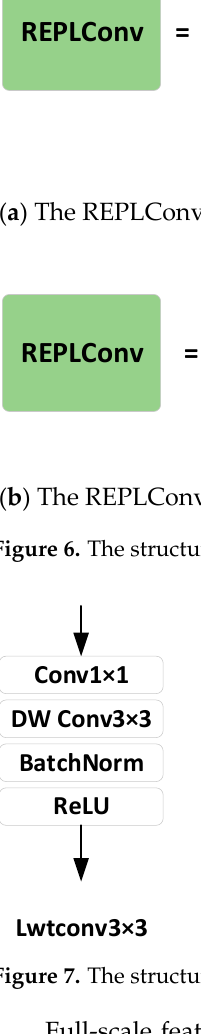
Figure 6. The structure of REPLConv.